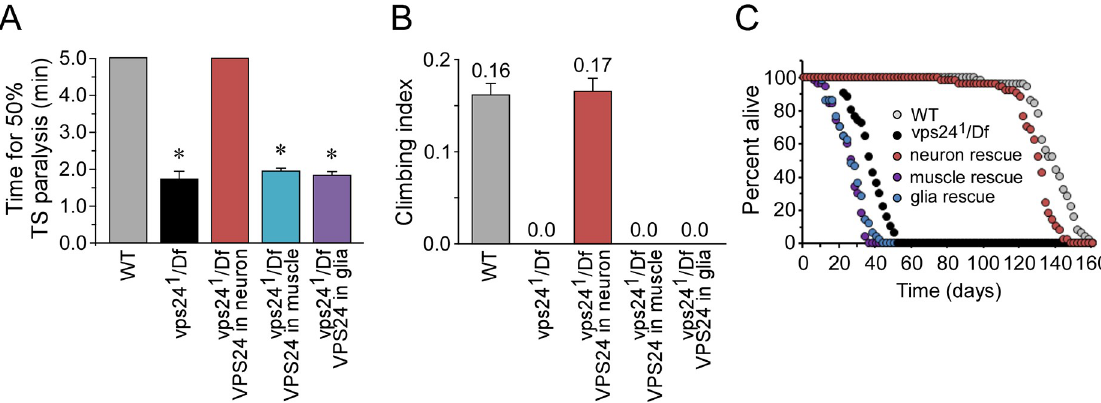
Fig 2. Neuronal expression of the wild-type VPS24 protein rescues the vps24 1 TS paralytic phenotype as well as locomotor and lifespan deficits. (A) The TS paralytic phenotype of the vps24 mutant was rescued by expression of the wild-type EGFP-VPS24 in neurons but not in muscle or glia. The GAL4 drivers for neuronal, muscle and glial expression were Appl-GAL4, Mhc-GAL4 and Repo-Gal4 respectively. (B) Climbing tests, carried out at a room temperature (RT) of 22–24˚C, indicated no detectable climbing ability in the vps24 mutant. The climbing tests were truncated at 2 min if 50% climbing had not occurred and zero was given for the climbing index. (C) Loss of the VPS24 function reduced lifespan with respect to WT when raised at a permissive temperature of 20˚C. These mutant phenotypes were rescued by expression of wild-type EGFP-VPS24 in neurons but not in muscle or glia. The same GAL4 drivers were used for subsequent cell-type specific expression studies.